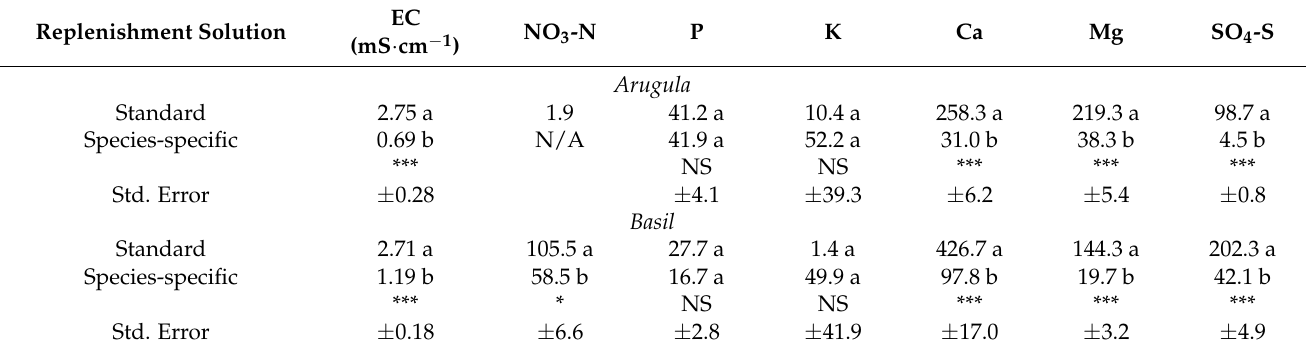
Table 4. Electrical conductivity (EC) and concentration (mg · L − 1 ) of nitrate-nitrogen (NO 3 -N), phos- phorus (P), potassium (K), calcium (Ca), magnesium (Mg), and sulfate (S) measured in solution for the standardized and species-specific replenishment solution treatments at 21